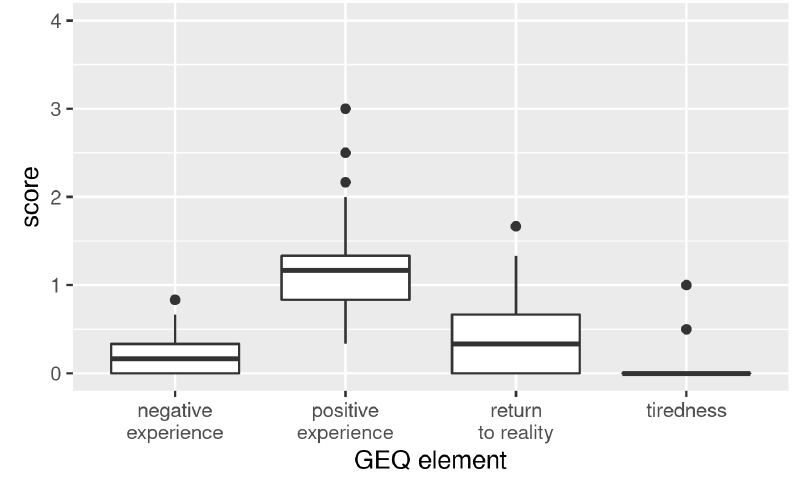
Figure 16. Box plot of average GEQ post-game